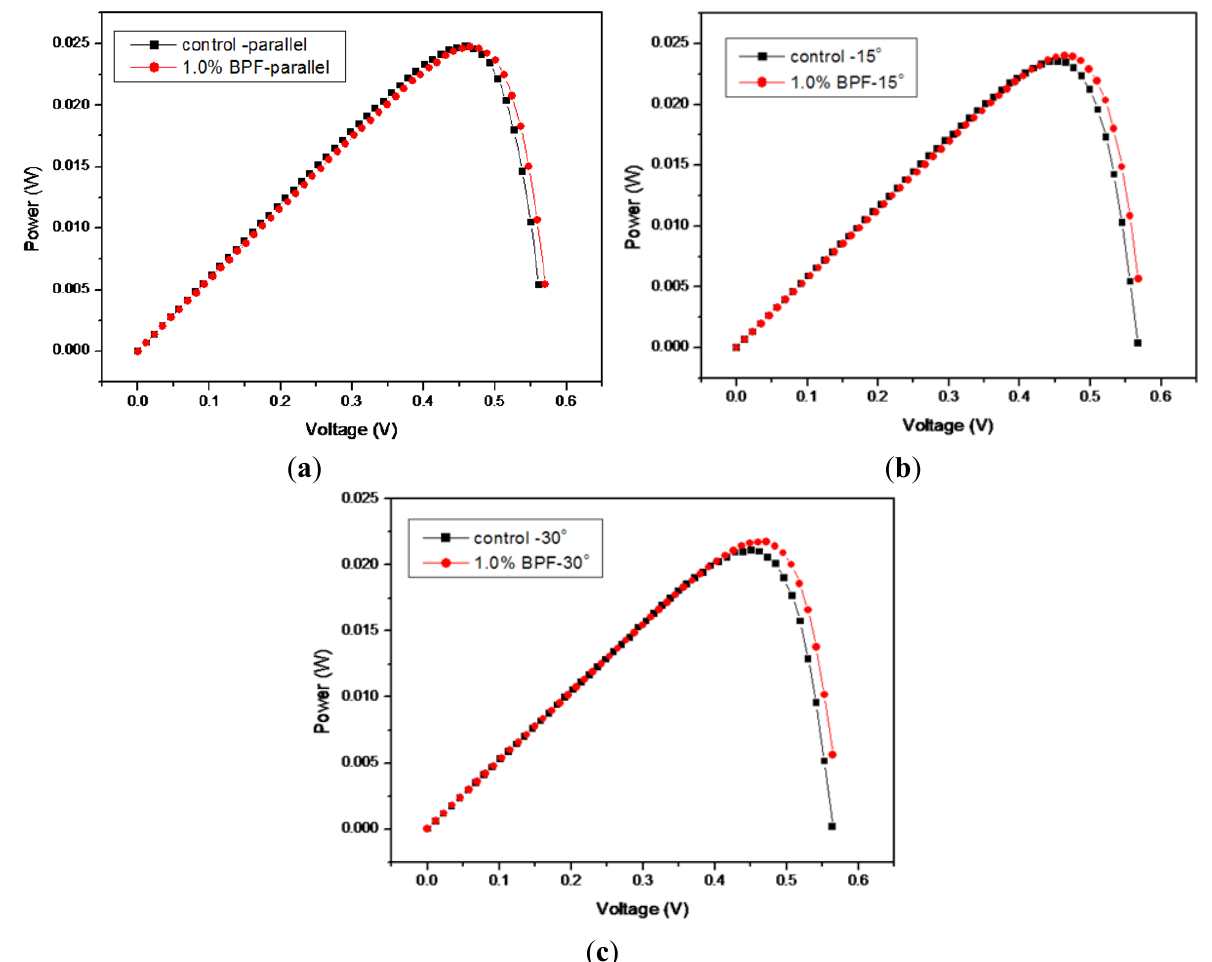
Figure 2. The measured P–V curves for the coated solar cell samples using 1% reactive mesogen precursor solution. The light incident angle has been 0° for ( a ); 15° for ( b ); and 30° for ( c ). The control solar cell sample data are also included for the ones without the liquid crystal polymer